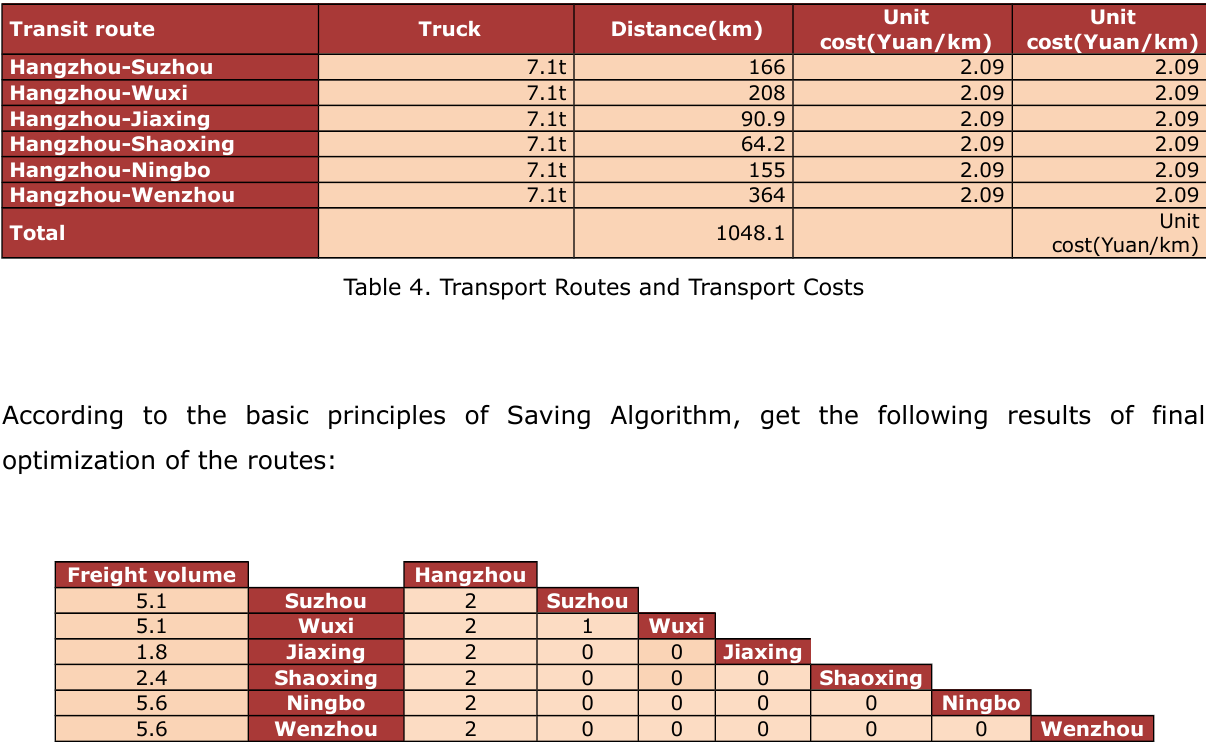
Table 5. The Final Optimization Results